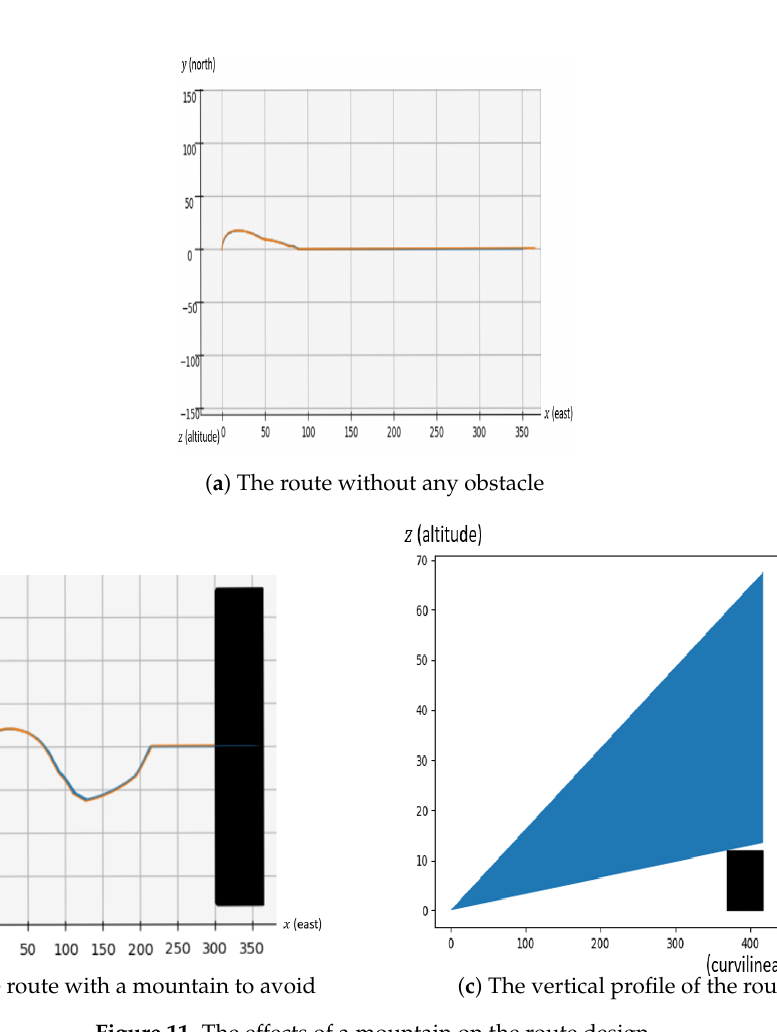
Figure 11. The effects of a mountain on the route design.